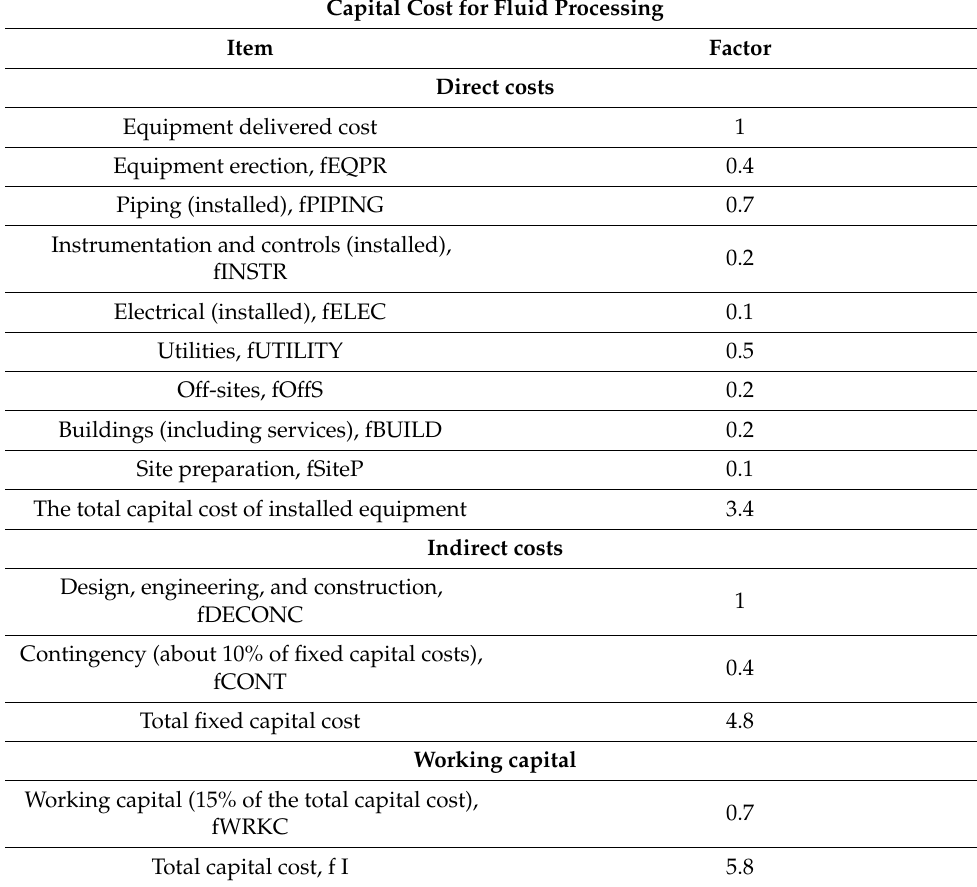
Table 3. Installation factors for the capital cost of